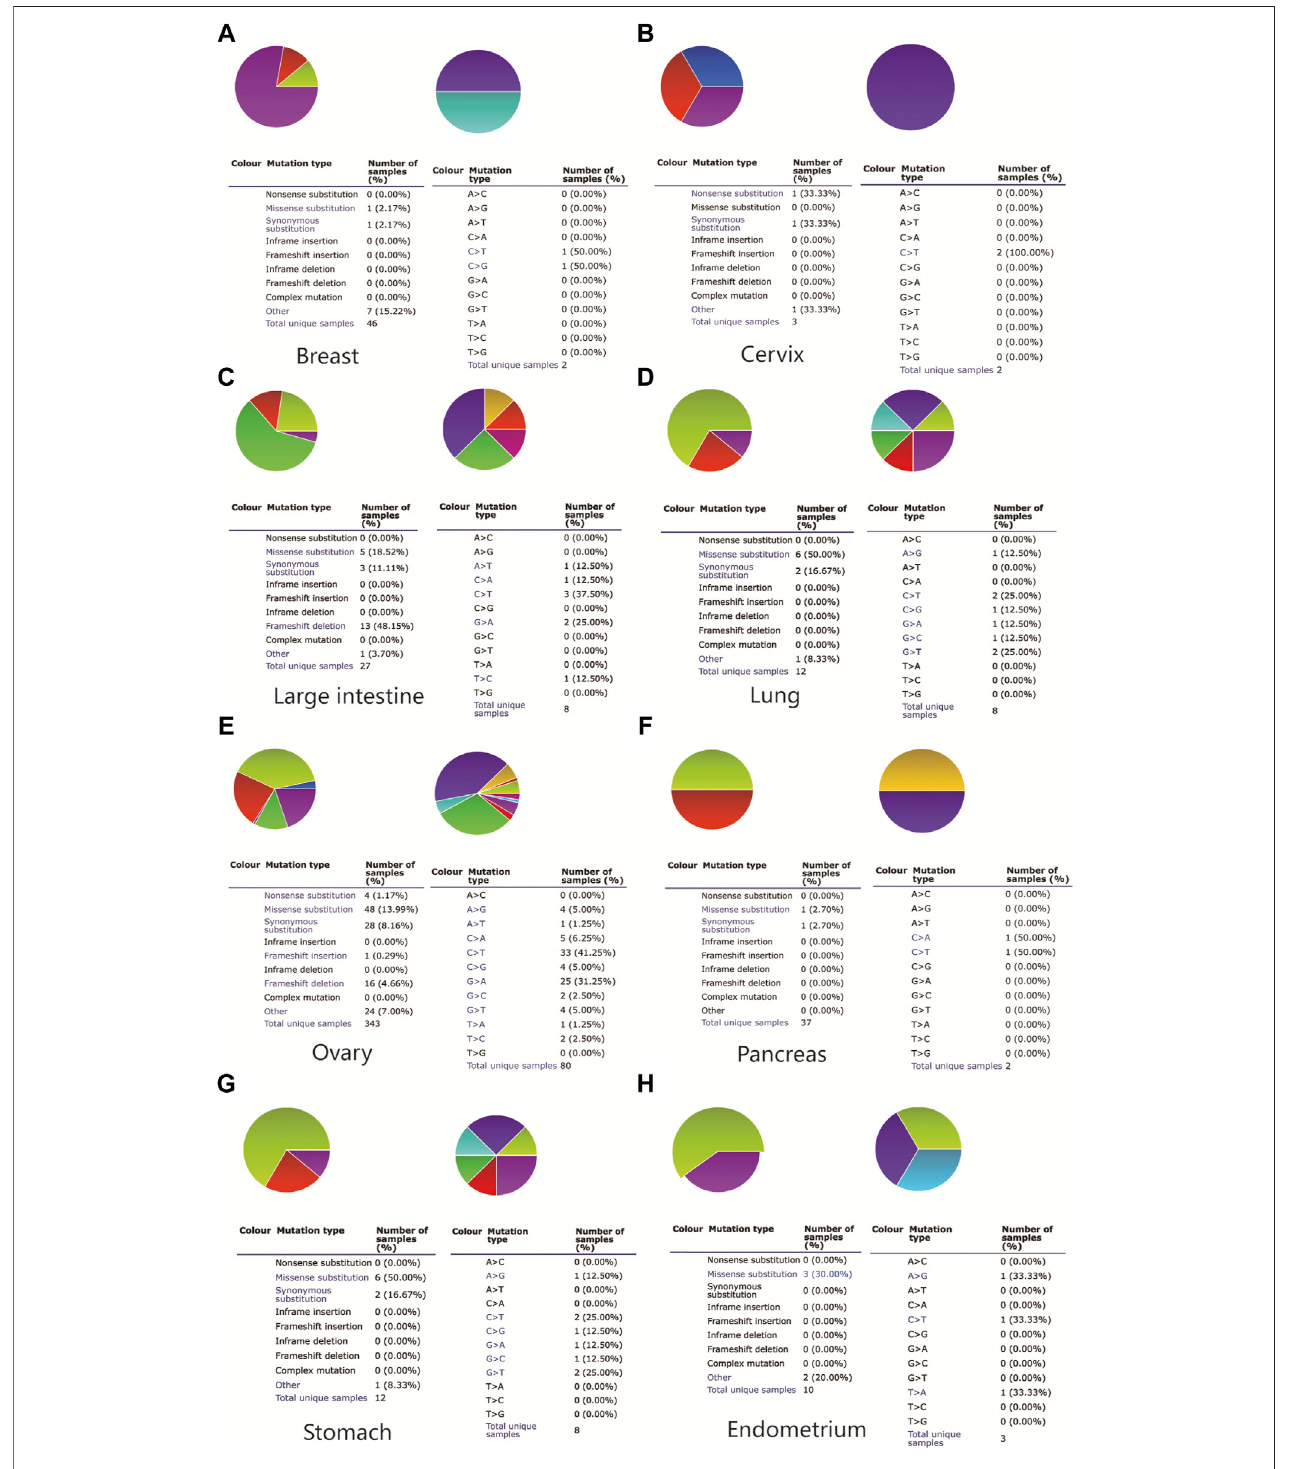
FIGURE2| ThesomaticmutationofMAL2inpan-cancers.ApiechartshowingthepercentageofthedifferentmutationtypesofMAL2inthebreast (A) ,cervix (B) , large intestine (C) , lung (D) , ovary (E) , pancreas (F) , stomach (G) , and endometrium (H) according to the Catalog of Somatic Mutations in Cancer (COSMIC) database.